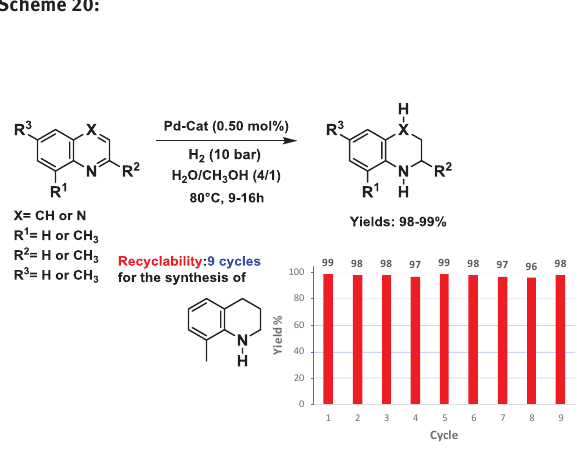
Scheme 20 Scheme 20: